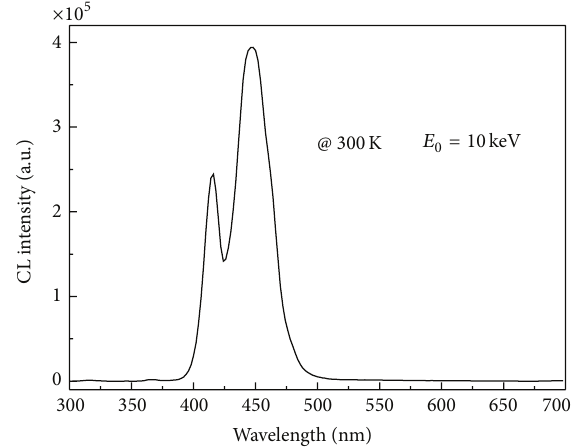
Figure 1: Room-temperature CL spectrum of the InGaN/GaN blue LED